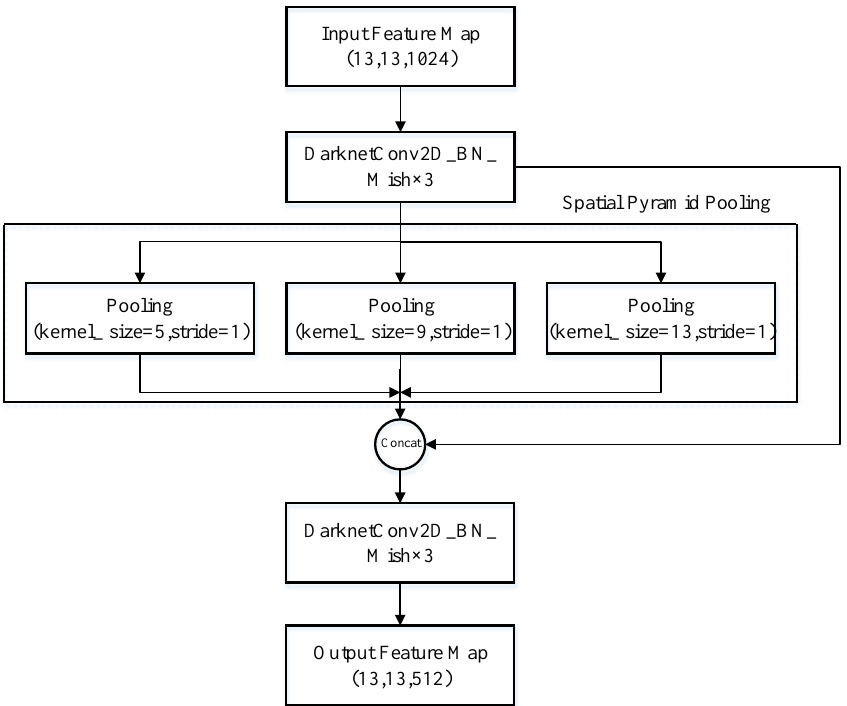
Figure 3. Improved spatial pyramid pooling (SPP) network structure.